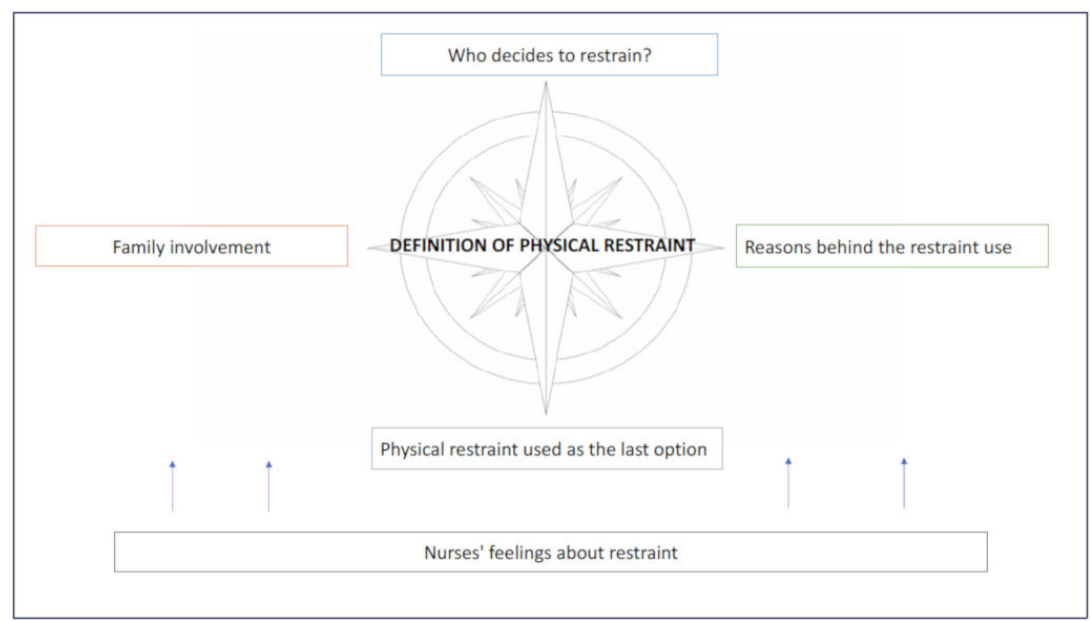
Figure 1. Overview of the emerged themes from nurses’ point of view on physical restraint